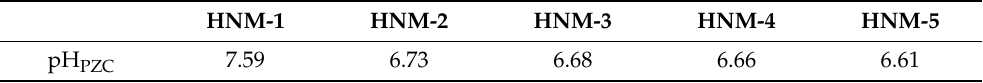
Table 1. The pH PZC value of HNM ‐ 1, HNM ‐ 2, HNM ‐ 3, HNM ‐ 4, and HNM ‐ 5.